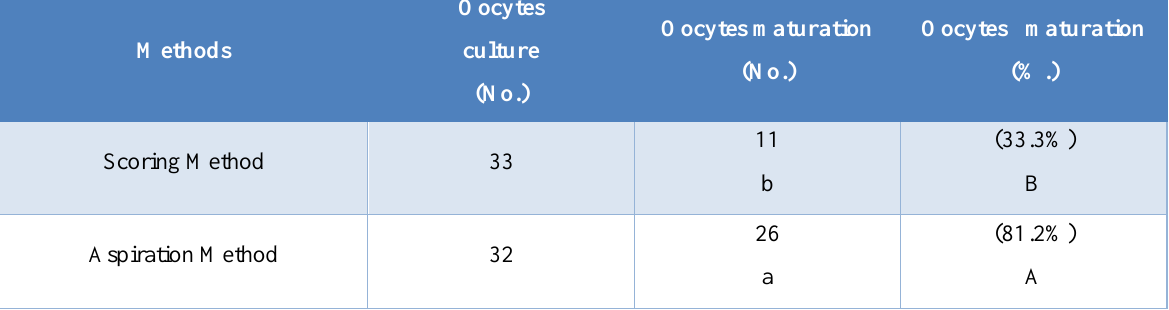
Table, 3: Effect of methods collection on In vitro maturation (IVM) of grading A and B oocytes. Methods